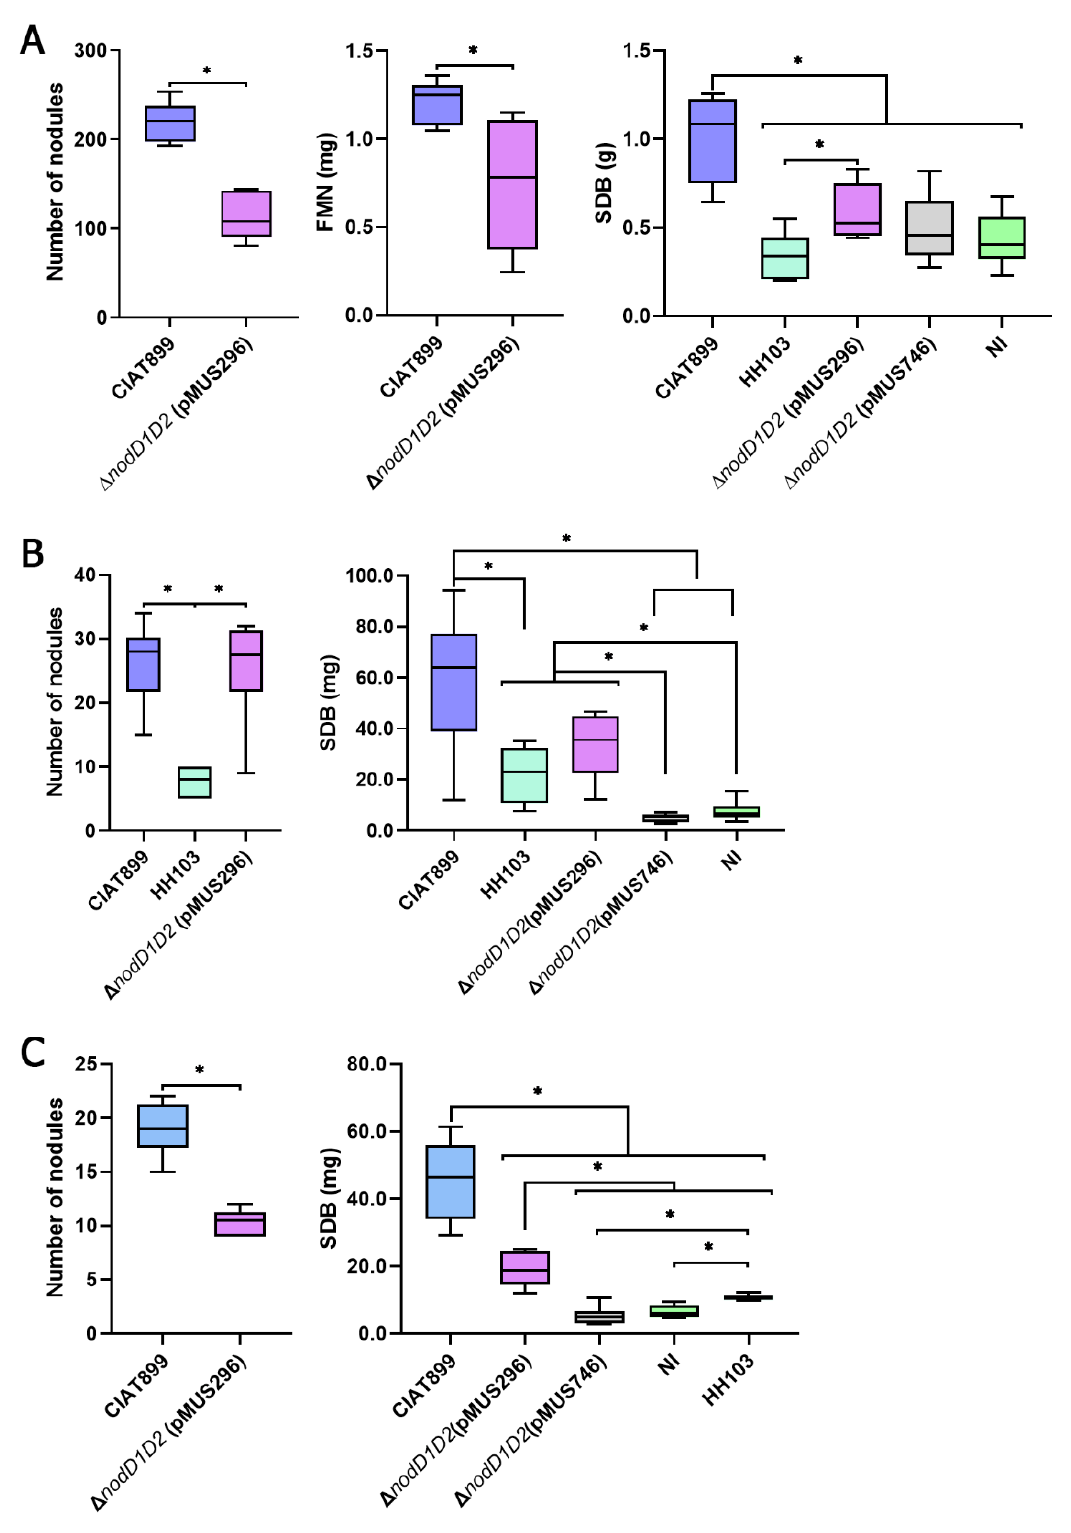
Figure 1. Symbiotic performance of S. fredii HH103, R. tropici CIAT 899, and CIAT 899 ∆ nodD1D2 carrying the nodD1 (pMUS296) or the nodD2 (pMUS746) gene of HH103 in Phaseolus vulgaris (panel ( A )), Lotus burttii (panel ( B )), and L. japonicus (panel ( C )). FMN, fresh mass of nodules. SDB, stem dry biomass. All treatments were compared to each other following the Mann–Whitney non-parametric test. Significant differences ( α = 0.5%) are denoted by asterisks.